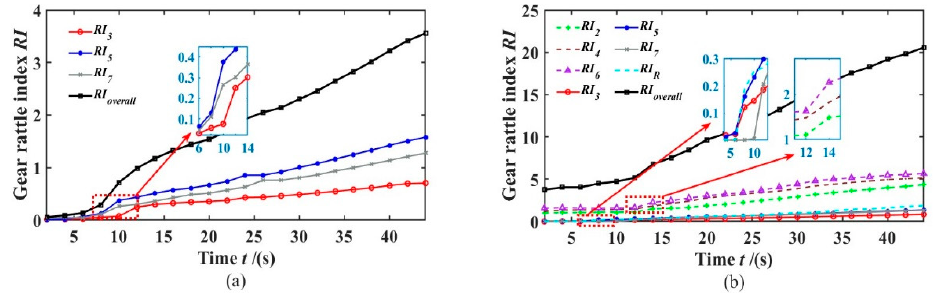
440 Figure 17. Comparison of the rattling intensity of each gear.